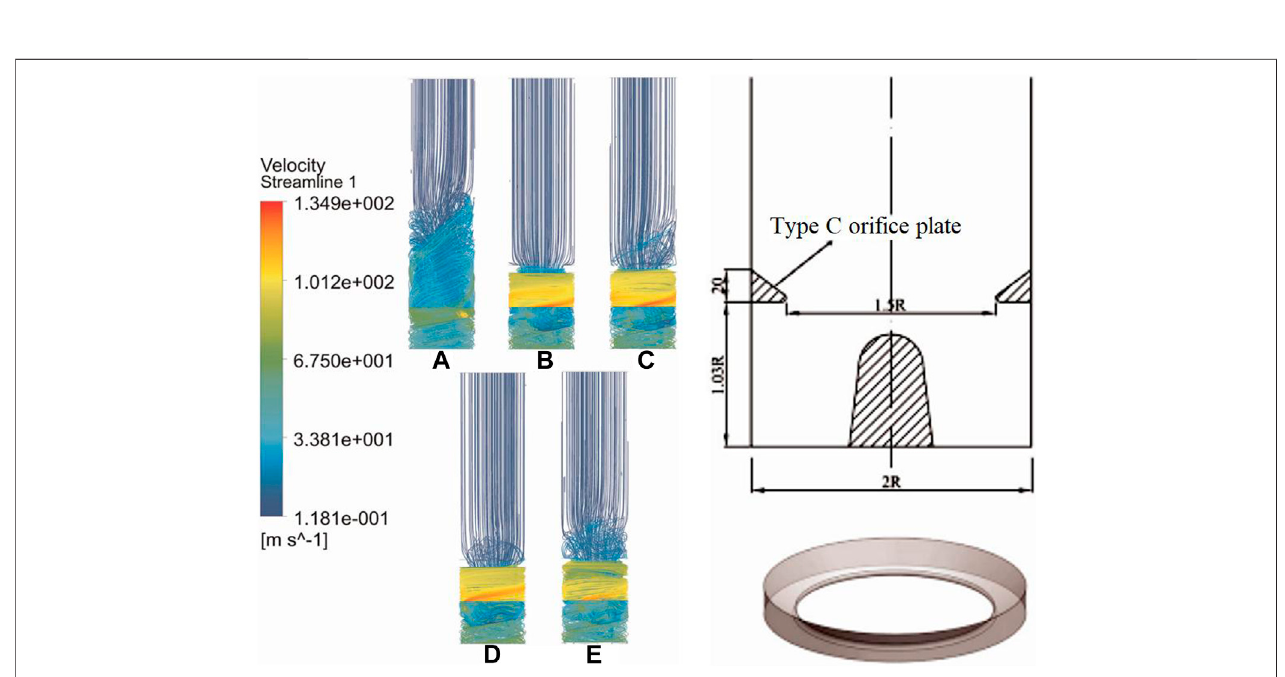
FIGURE8| Streamlinesofdifferentori fi ceplatesandc-typeori fi ceplatestructures: (A) withoutori fi ceplate, (B) typeAori fi ceplate, (C) typeBori fi ceplate, (D) type C ori fi ce plate, and (E) type D ori fi ce plate (Wenwu Song, 2017).